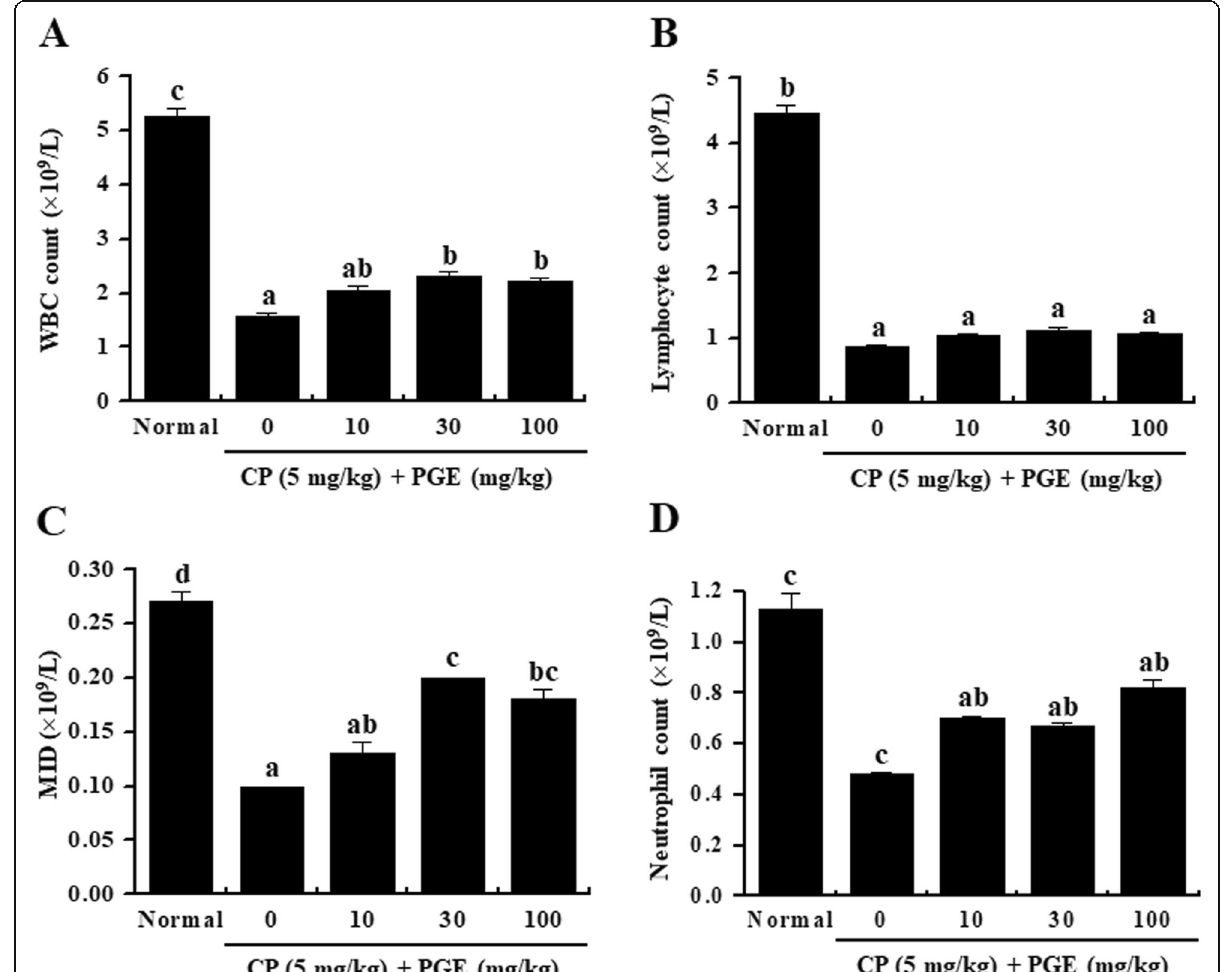
Fig. 6 Effects of PGE on inflammatory cell counts in the whole blood of CP-induced immunosuppressed rats. Rats were given saline, CP (5 mg/ kg/day), and PGE (0, 10, 30, or 100 mg/kg/day) once daily for 28 days, after which whole blood samples were collected for analysis. a – d The levels of inflammatory cells (WBCs, lymphocytes, MID, and neutrophils) in the blood samples were determined using a Hemavet 950 system. Bars labeled with different superscripts have significantly different values ( P < 0.05). Data are presented as the means ± standard errors ( n =